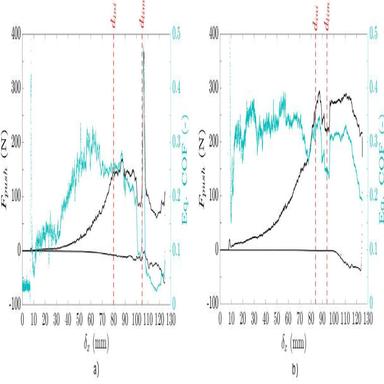
Load-displacement (left axis) and equivalent COF-displacement (right axis) curves for (a) rigid (T4-01) and (b) flexible (T5-01) adhesive samples, tested following the WDT+ method.